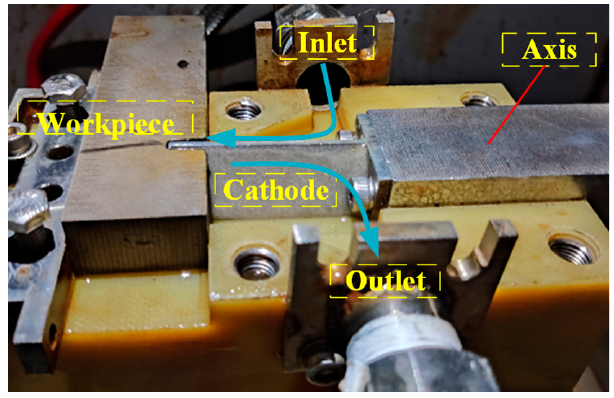
Figure 12. Electrochemical machining fixture.